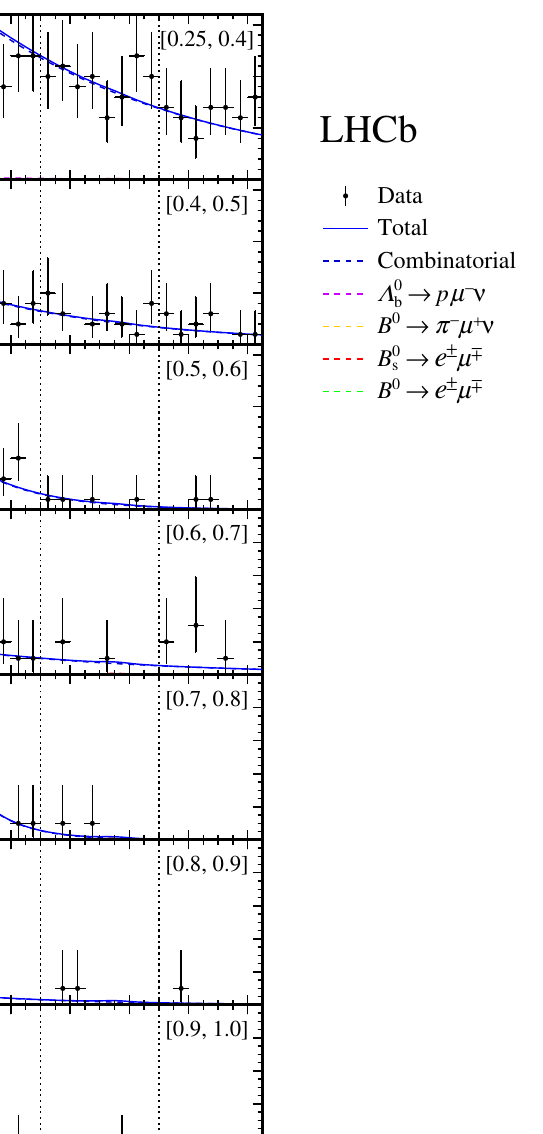
! e (cid:6) (cid:22) (cid:7) candidates, m , divided e (cid:6) (cid:22) (cid:7) ( s )